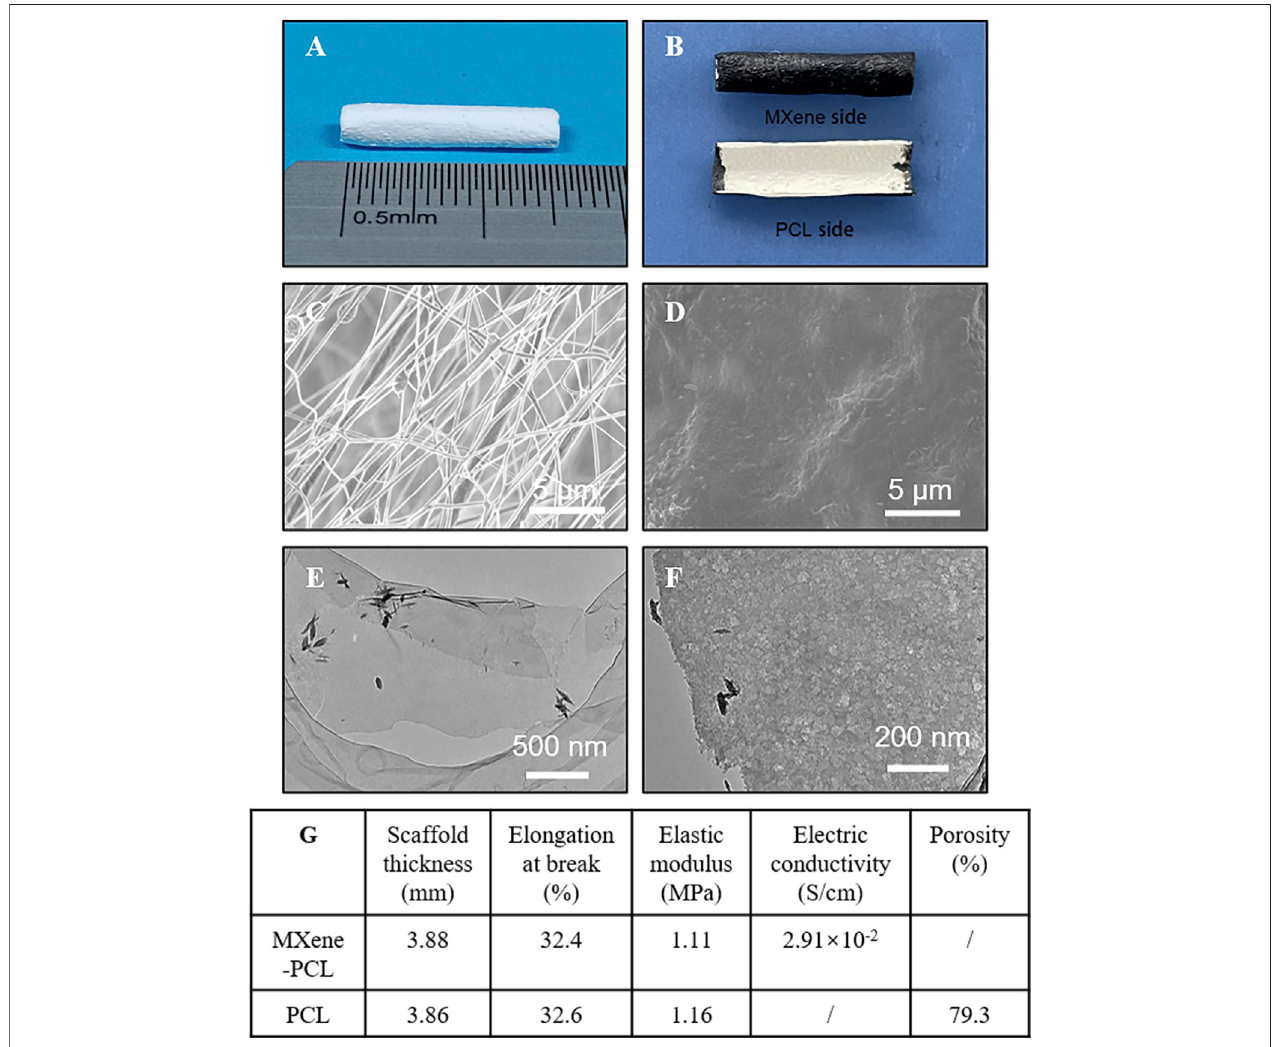
FIGURE 2 | Materials characterization. Representative optical microscope pictures of the PCL NGC (A) , and MXene-PCL NGC (B) . SEM images photographed from PCL side (inner surface) (C) and the Mxene side (outer surface) of the MXene-PCL NGC. Low- (E) and high-magni fi cation TEM image (F) of d-Ti 3 C 2 MXene nanosheets. Summarizing table of the MXene-PCL and PCL scaffolds ’ mechanical and electrical characteristics (G) .